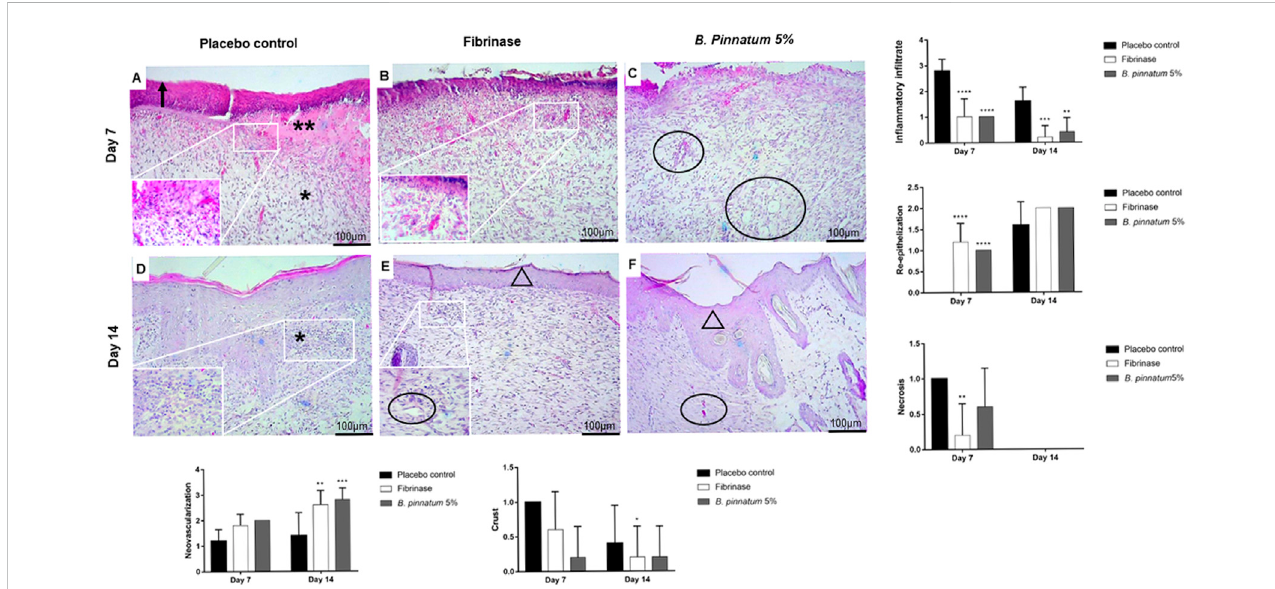
FIGURE 6 HistologicalcharacteristicsofrepresentativesamplesofskinwoundbiopsiesfromthebackofWistarrats.Hematoxylin – eosin(H&E)stainingshowingthe sectioningofthebiopsies inthetransverse direction.Viewunder abright fi eldmicroscopeat10 ×magni fi cation andzoom at40× magni fi cation. Placebo gel, Fibrinase ® , and gel containing B. pinnatum leaf extract groups evaluated on day 7 [ (A,B,C) respectively] and on day 14 [ (D,E,F,) respectively]. Arrow indicates crust. Two asterisks indicate fi brin and coagulation region. An asterisk indicates in fl ammatory in fi ltrate. Circle indicates neovascularization. Triangle indicates re-epithelialization. Statistical difference demonstrated by Mann – Whitney test ( n = 5), * p < 0.05, ** p < 0.01, *** p < 0.001, and **** p < 0.0001 vs . placebo